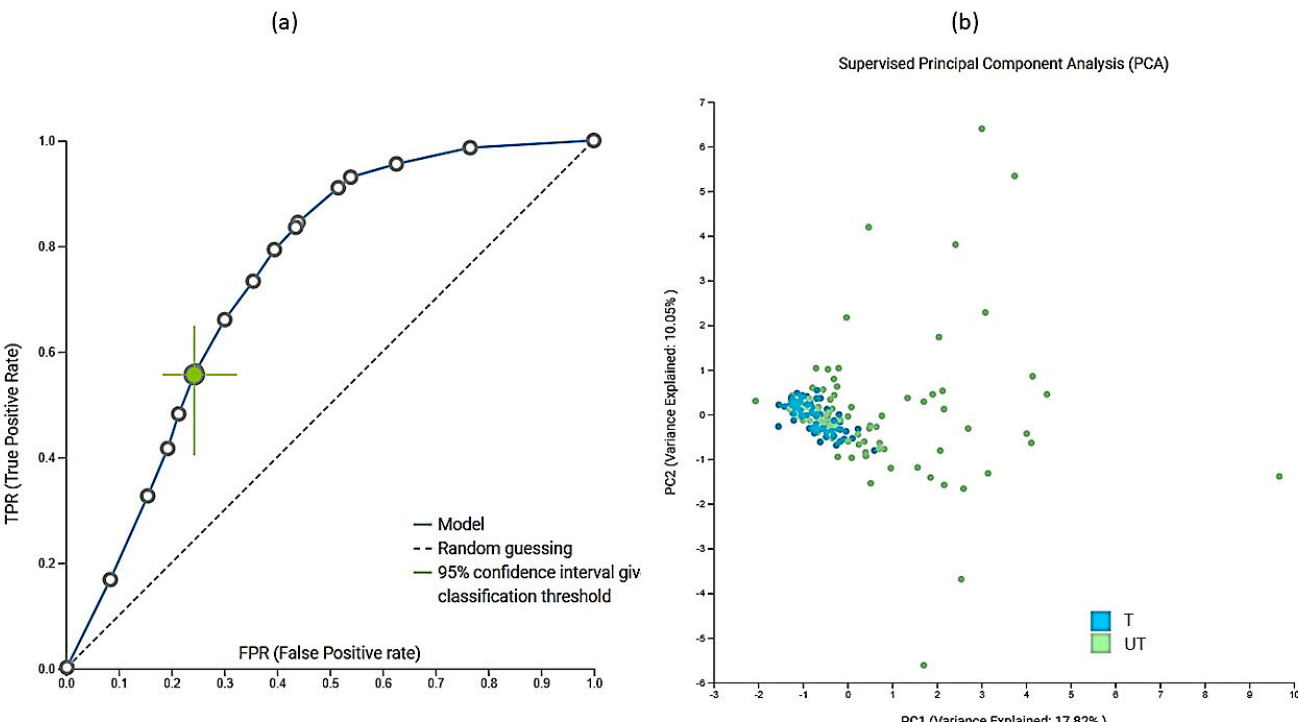
Figure 6. The receiver operator curve (ROC) ( a ) plot and PCA plot ( b ) of modeled data. The dimen- sionality reduction was performed within JADBio on a subset of the original dataset, keeping only the features included in the first signature. Features were standardized with statistical normalization ((x − µ )/ σ ). A total of 155 samples were included in this analysis for training the model from the entire dataset. A total of 72 samples belonged to trained and 82 samples belonged to untrained group.